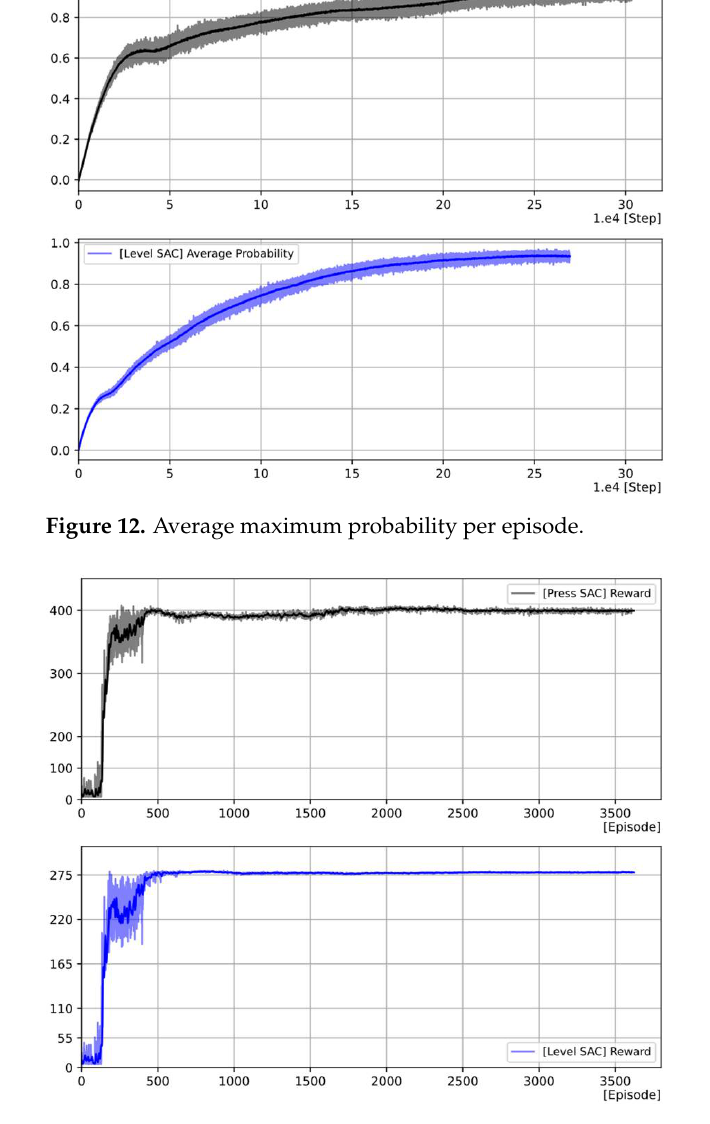
Figure 13. Reward per episode.